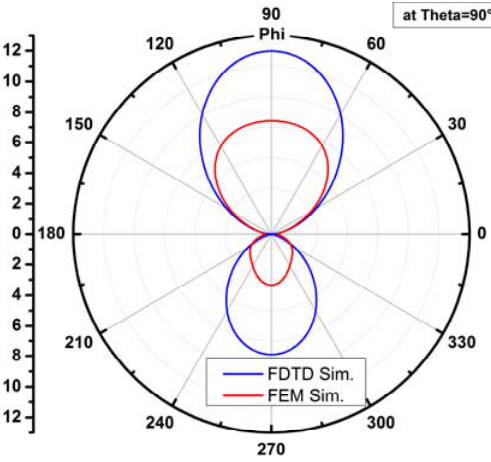
Figure 4: Radiation pattern of the proposed at 24 GHz in linear scale at xy- plane